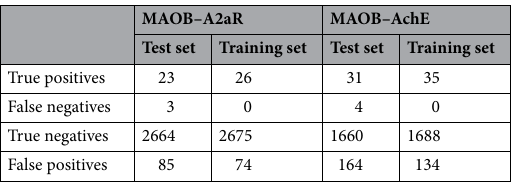
Table 2. Elements of the confusion matrix for test and training